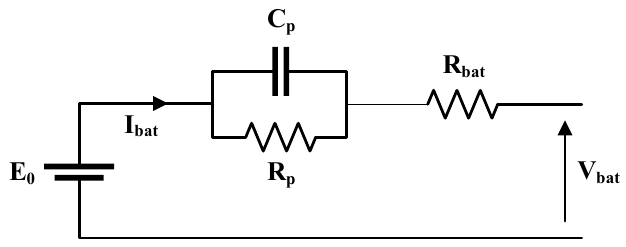
Figure 4. Electric model of